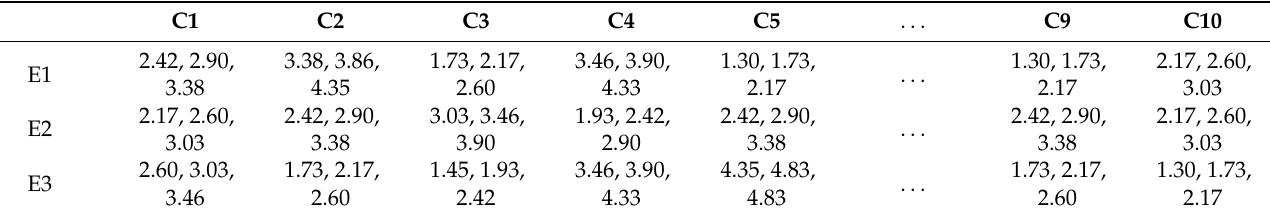
Table 4. Transformed Z-numbers into classic fuzzy